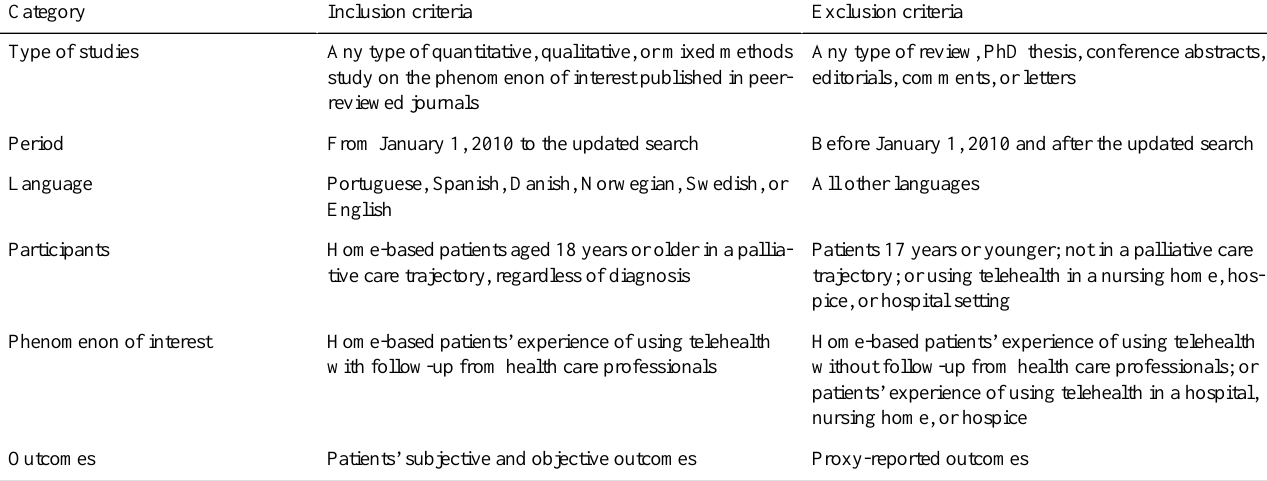
Table 1. Inclusion and exclusion